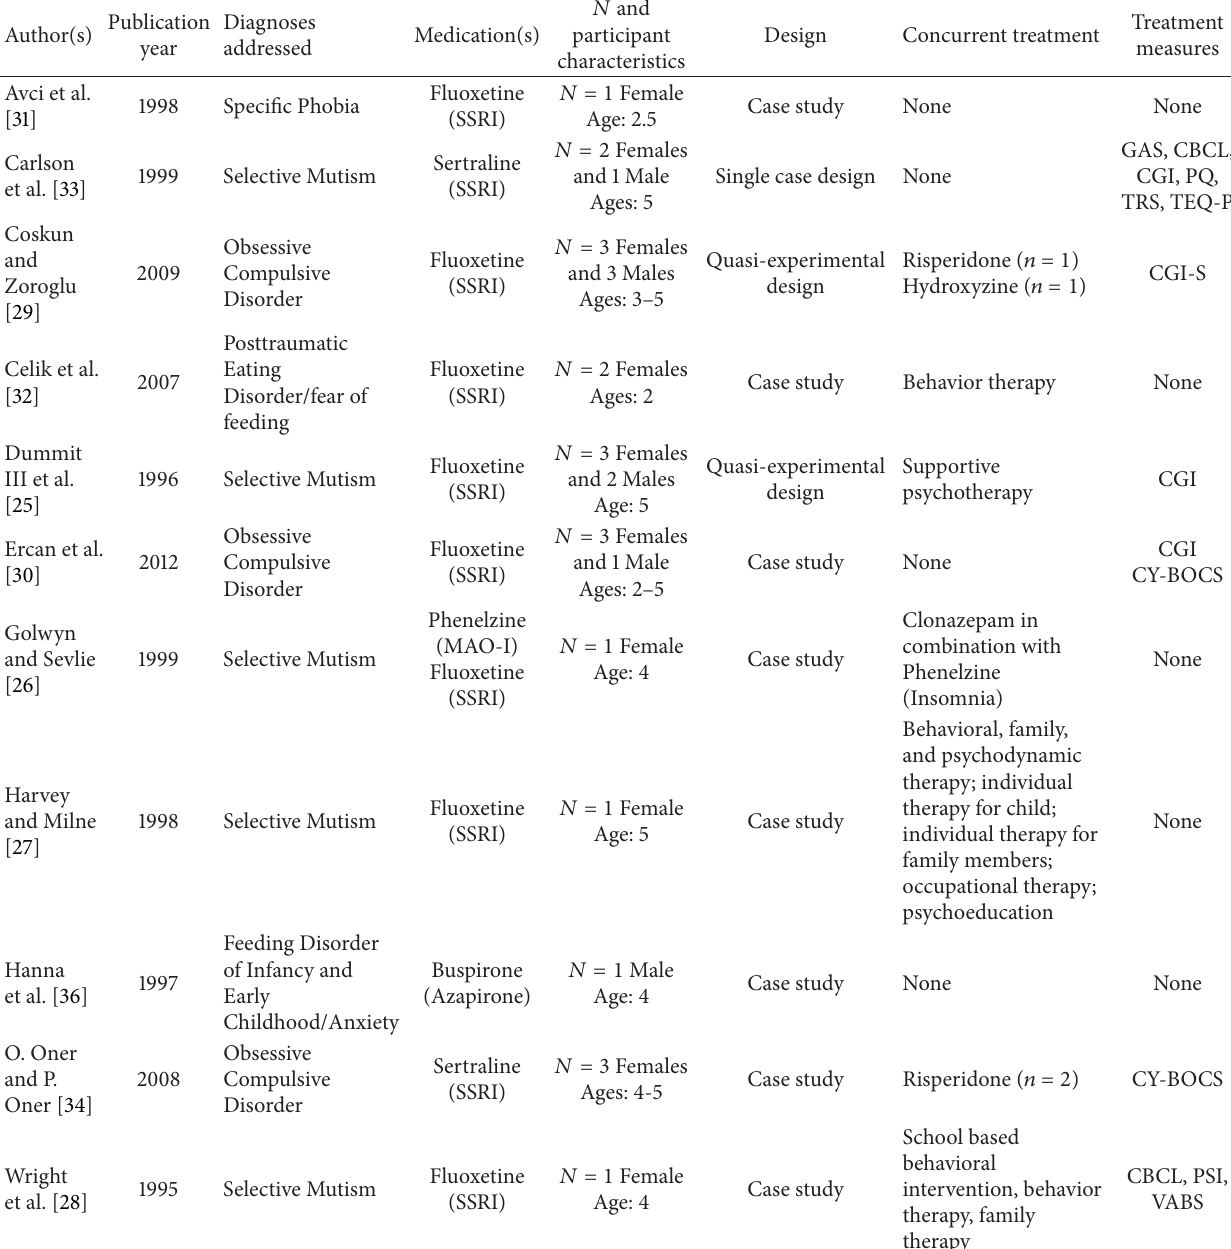
Table 1: Characteristics of identified